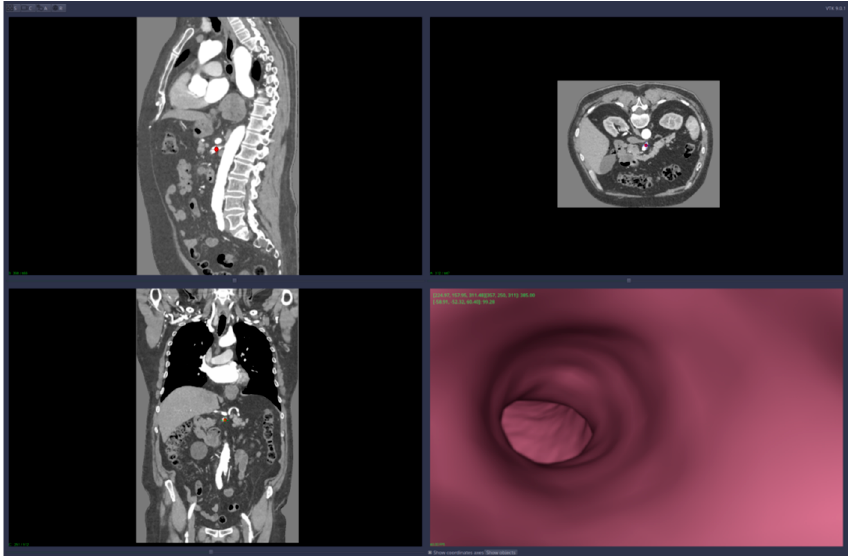
Figure 5. Virtual angiography—“normal” zone of the mesenteric artery, after the aneurysm (direction is opposite to the blood flow).